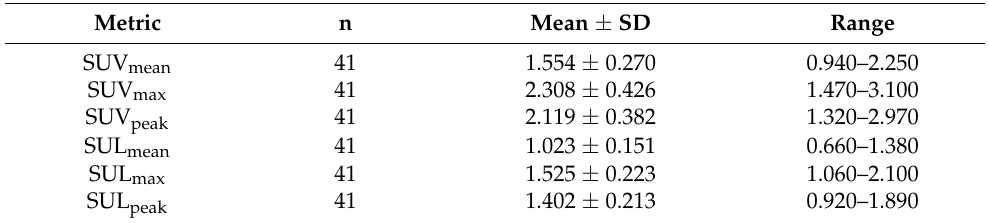
Table A1. The mean uptake metrics measured in the SCV. The table includes the number of cases/patients (n), the standard deviation (SD), minimum and maximum (range)